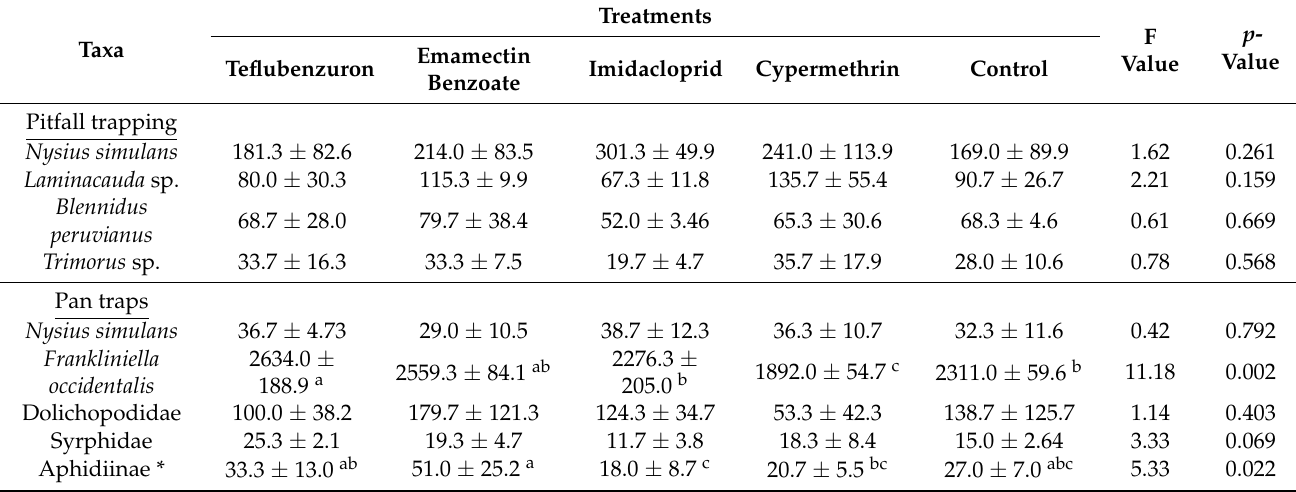
Table 3. Cumulative numbers (mean no. per trap ± standard deviation) of the most abundant phytophagous insects and natural enemies, collected with two sampling methodologies, after the second insecticide application (sampling